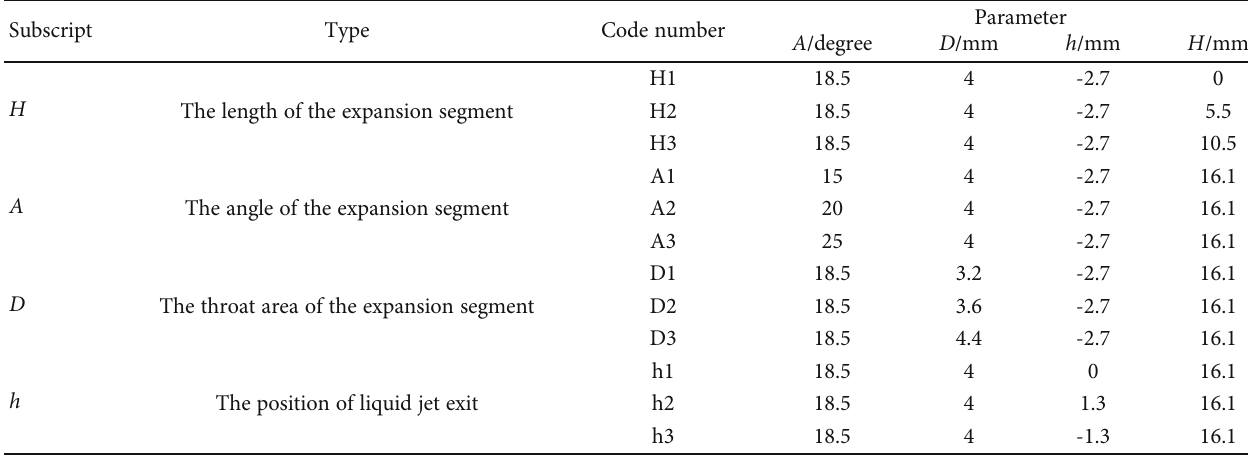
Table 1: Geometrical con fi gurations adopted in the study.